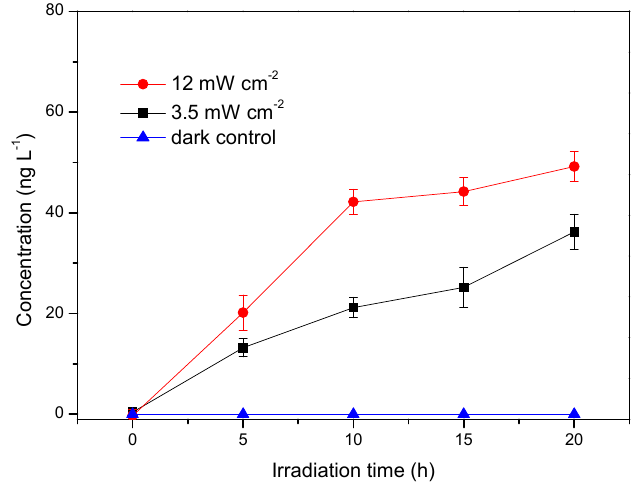
Figure 1. Effect of light intensity on the production of methyl chloride. Reaction conditions: [Cl − ] = 0.5 mol L − 1 , [HA] = 5 mg L − 1 , pH = 6.5.